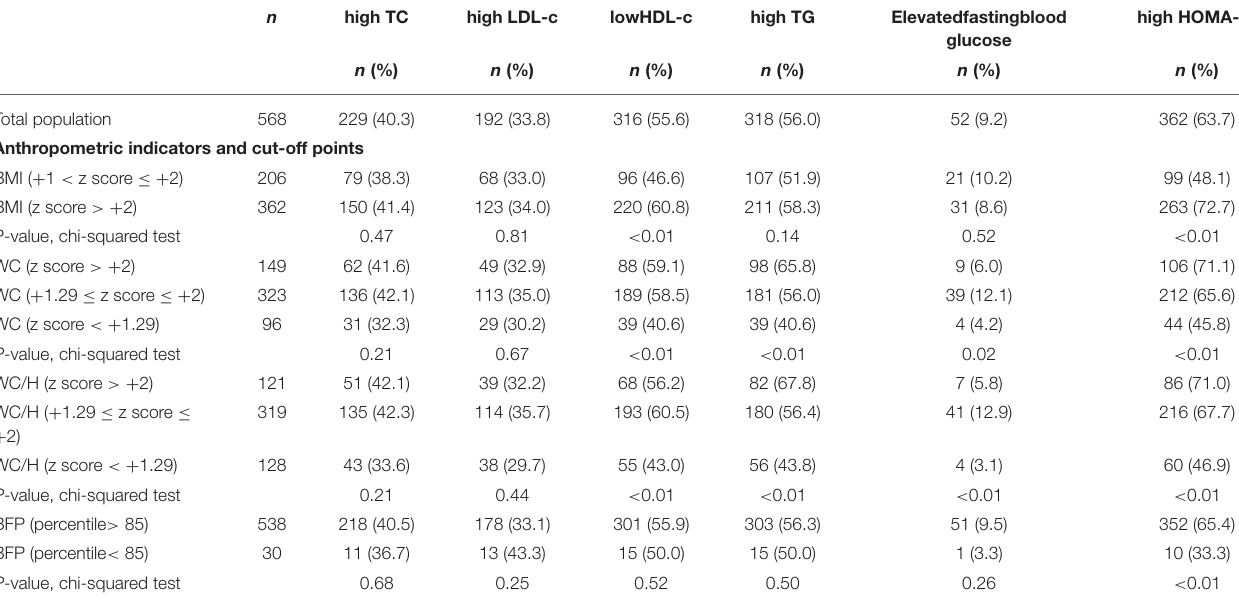
TABLE 2 | Prevalence of dyslipidemia, hyperglycemia, and insulin resistance according to the cutoff points of different criteria for defining excessive